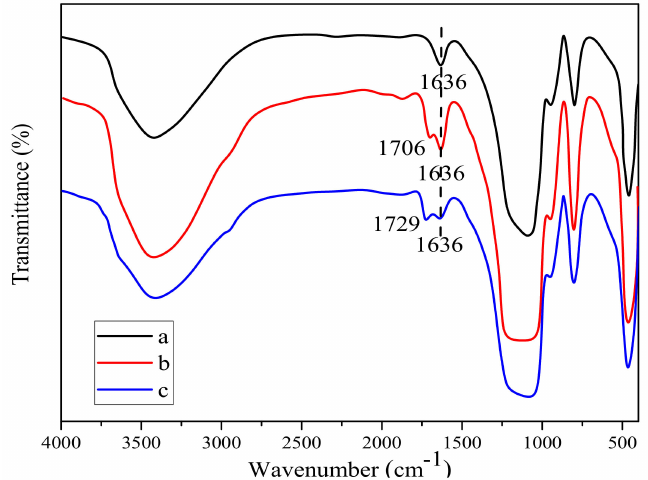
Figure 13. FTIR spectra of samples: only silica sol ( a ), KH550 grafted silica sol ( b ), and C-P film ( c